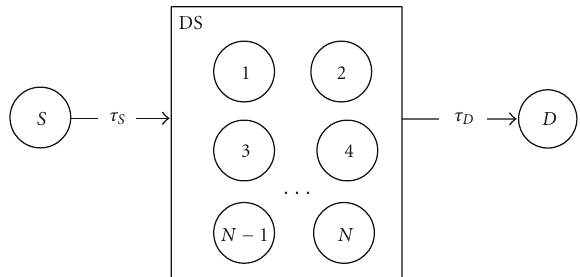
Figure 3: End-to-end message delivery under dominating-set- based